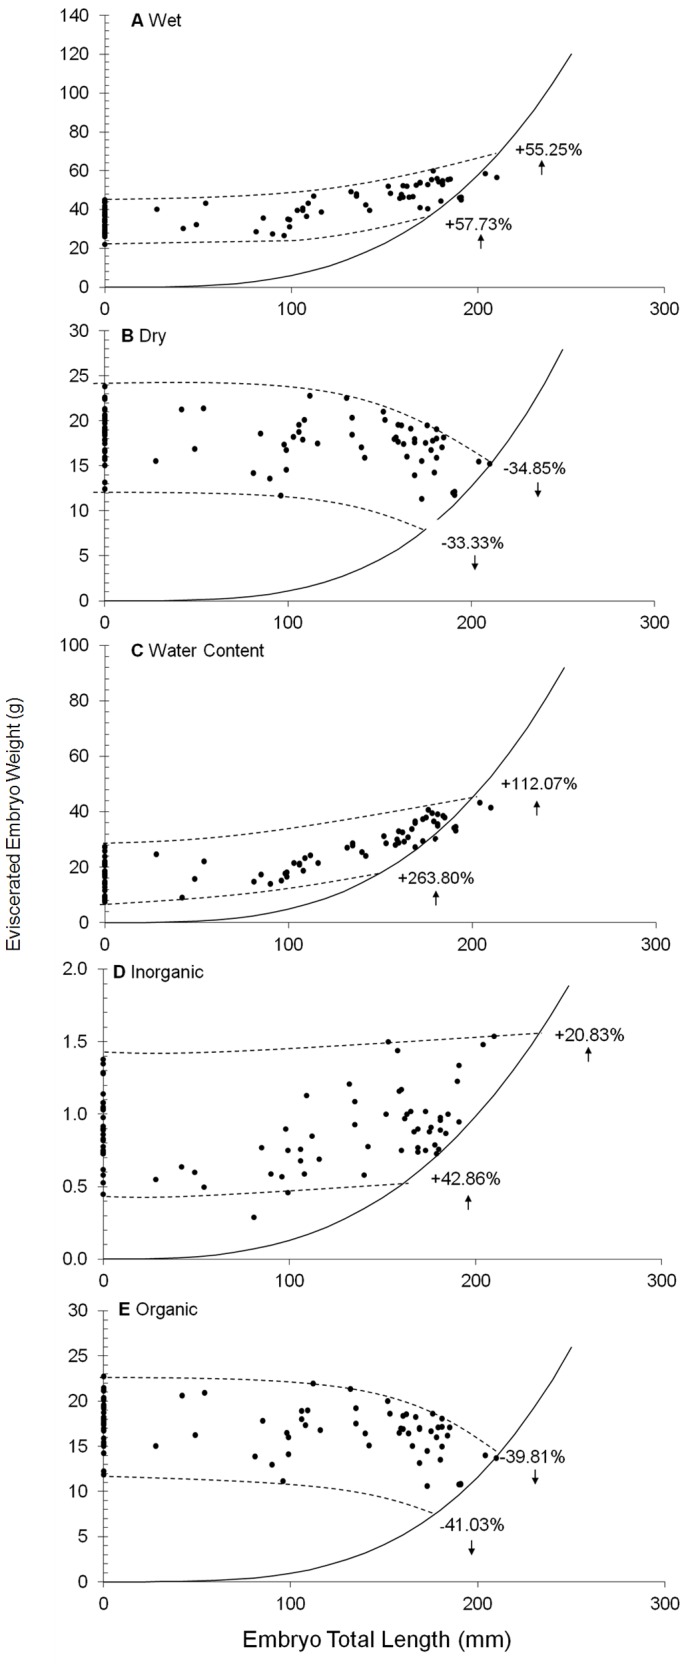
Percentage mass change throughout embryonic development for different constituents.Relationship between embryo total length (TL) and (a) total wet mass (n = 82), (b) total organic matter (n = 81), (c) total inorganic matter (n = 81) and (d) total water content (n = 82) of Heterodontus portusjacksoni embryonic system at different developmental stages; the solid line represents the eviscerated embryo mass (without external and internal yolk sacs) and embryo TL relationship; the parallel lines were designed to include all the data points, following the proposed method by Guallart and Vicent [15] and the intersection of the parallel lines with the eviscerated embryo mass–TL relationship indicates the mass change corresponding to the extremes of variability of egg size.